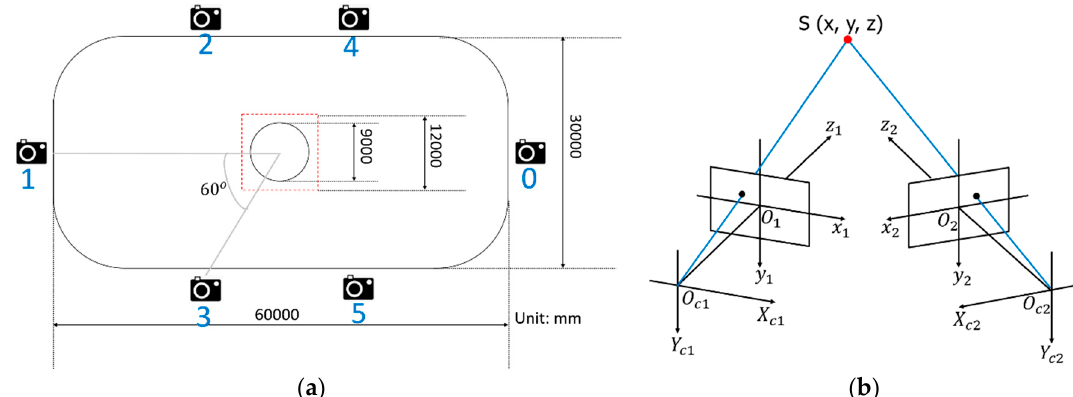
Figure 3. Six cameras are placed in the audience. The camera’s field of view is centered on the red dotted frame. Any two synchronized cameras which can form a distinct triangle with the athlete can reconstruct a spatial point. ( a ) The size of the venue and the location of camera; ( b ) binocular stereo